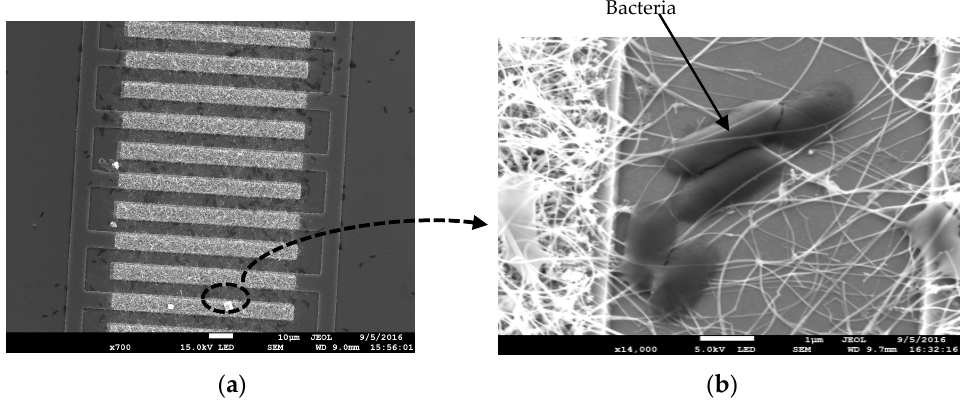
Figure 3. ( a ) SEM observation illustrating bacteria (dark spots) preferentially hanged on the SiNWs; ( b ) zoom of bacteria hanged into SiNws network between the interdigitated electrodes of the resistor characteristics of SiNWs based resistor with and without bacteria.